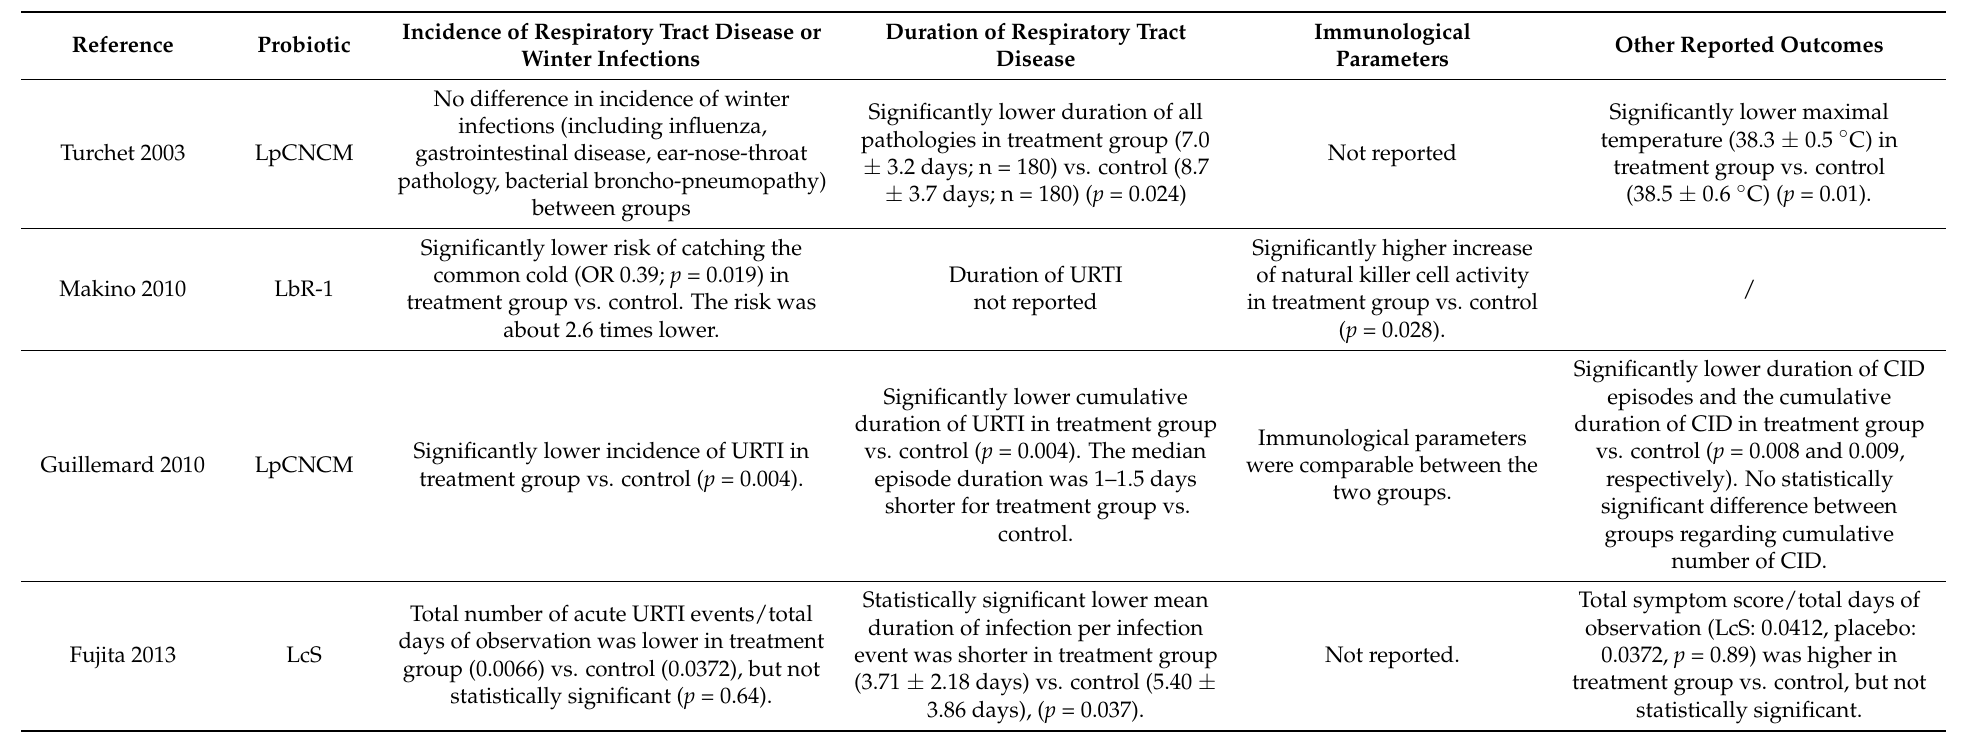
Table 5. Reported outcomes of eight clinical studies on the effects of fermented drinks with probiotics and probiotic food supplements against acute upper respiratory tract infections in older